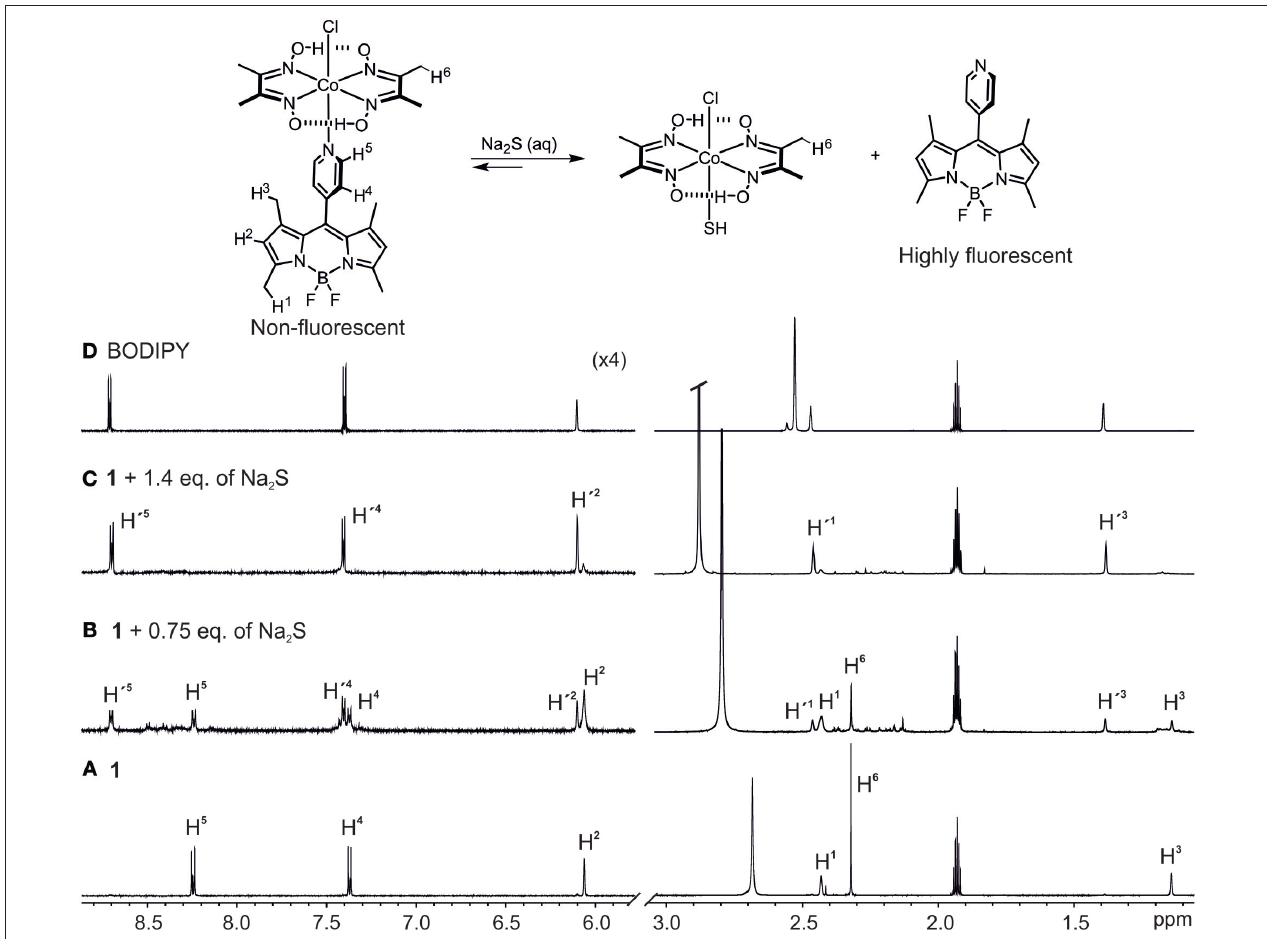
FIGURE 4 | Selected regions of the 1 H-NMR spectra (400 MHz, CD 3 CN/5% D 2 O) of: (A) 1 , c 1 = 8.0 × 10 − 3 mM, (B) 1 + 0.5 eq., of Na 2 S in D 2 O, (C) 1 + 1.4 eq., of Na 2 S in D 2 O, and (D) free BODIPY in CD 3 CN. Primed numbers indicate free BODIPY